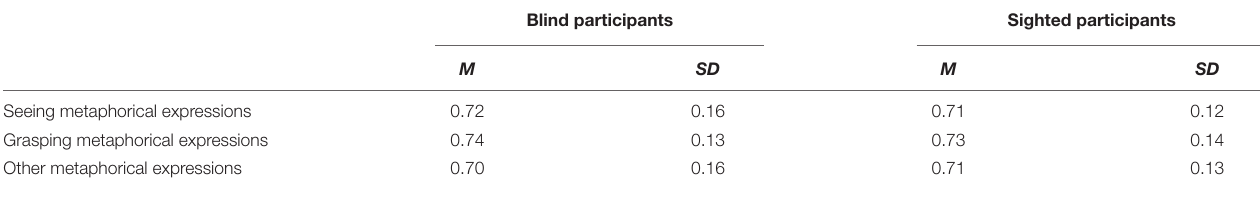
TABLE 2 | Mean proportions of correct answers for the comprehension of metaphorical expressions by blind and sighted participants, Experiment 2. Blind participants Sighted